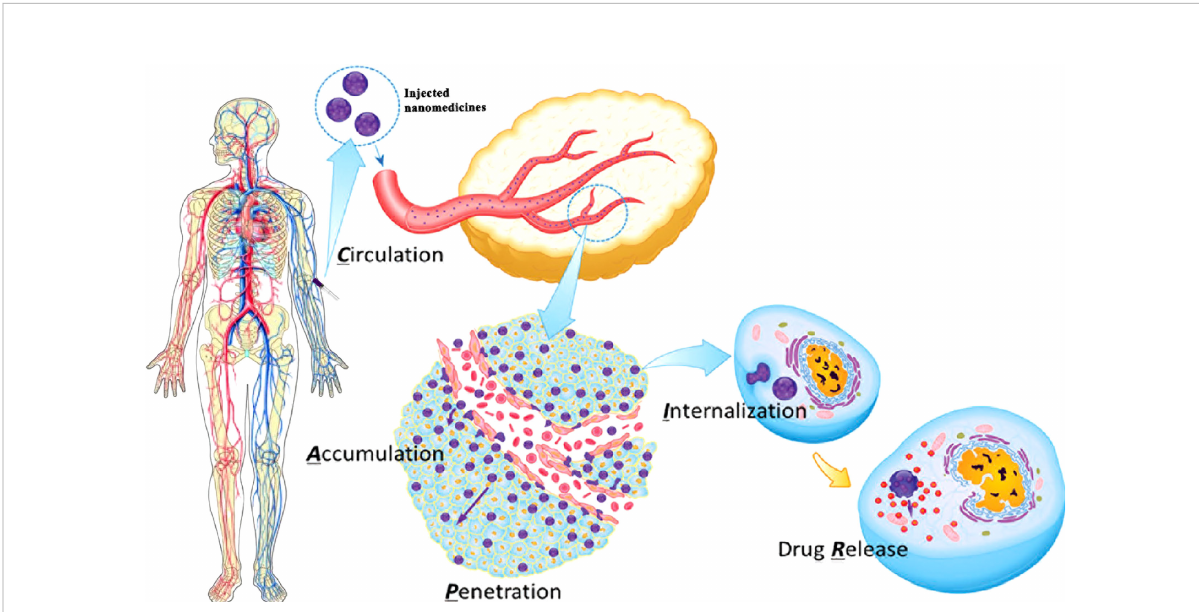
FIGURE 1 The fi ve-step CAPIR cascade for nanomedicines to deliver free drugs into tumor cells. C step: nanomedicines should be stable and stealthy for long blood circulation, which means nanomedicines should be large (about 100 nm), and the surface should be pegylated and neutral and hide binding groups. A step: nanomedicines should speci fi cally accumulate in tumor site through enhanced permeability and retention (EPR) effect and interaction between the surface ligand on nanomedicines and receptors on tumors. P step: nanomedicines should be small (less than 30 nm) and show a positive charge on the surface for effective tumor penetration. I step: nanomedicines should show positive charge and speci fi c ligands/functional groups on surface to stick to tumor cells for fast cellular internalization. R step: nanomedicines should release the active drug in a “ smart ” manner modulated by tumor microenvironment (TME) characteristics (5, 6). Figure reproduced with permission (4). Copyright, 2014 WILEY ‐ VCH (License Number: